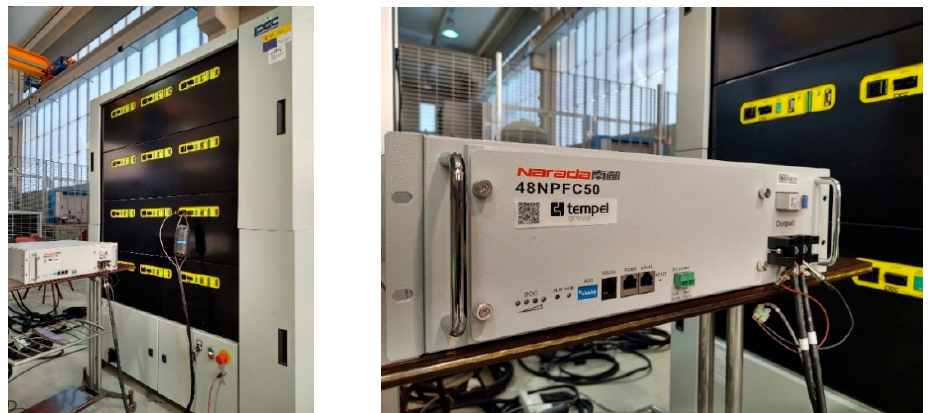
Figure 1. Left: Laboratory facility for battery testing. Right: Battery connected to SBT-10050 test equipment.